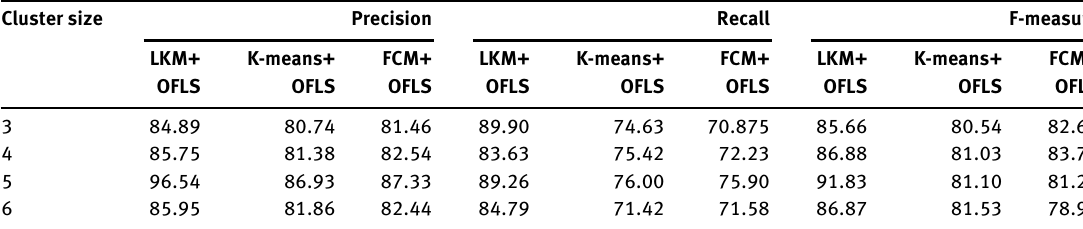
Table 6: Performance Analysis by Varying Cluster Size. Cluster